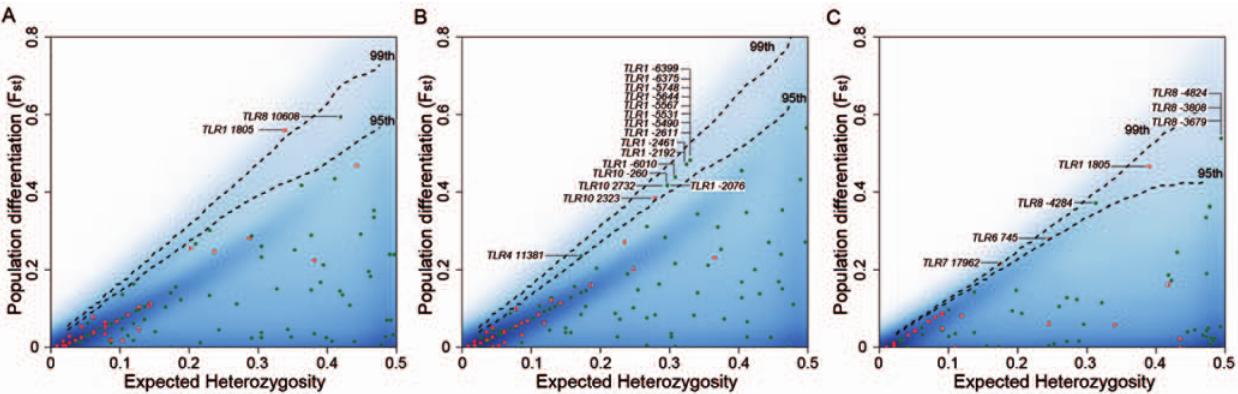
Figure 4. Some TLR members present extreme levels of population differentiation. (A) F ST comparison for Africans vs Europeans (B) F ST comparison for Africans vs East-Asians and (C) F ST comparison for Europeans vs East-Asians. To account for possible differences in the allele frequency spectrum between our data and the HapMap genome-wide distribution [59], we compared F ST as a function of heterozygosity. Green dots correspond to silent polymorphisms and red dots correspond to nonsynonymous mutations. The dashed lines represent the 95 th and 99 th percentiles of the HapMap genome-wide distribution (represented by the density area in blue). The significant values observed for TLR7 and TLR8 should be taken cautiously because these genes are located on the X chromosome and therefore, higher genetic drift may have exacerbated the levels of population differentiation observed.